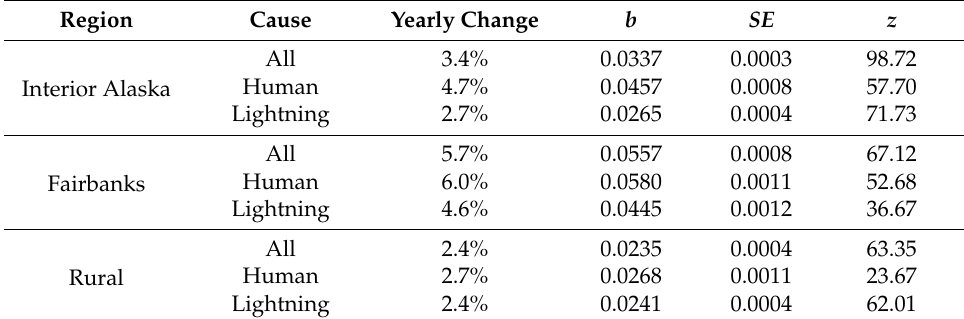
Table 3. Temporal trends in fire duration in interior Alaska as a whole, the Fairbanks subregion, and rural interior Alaska by cause of ignition as determined by linear regression for 1990–2016.